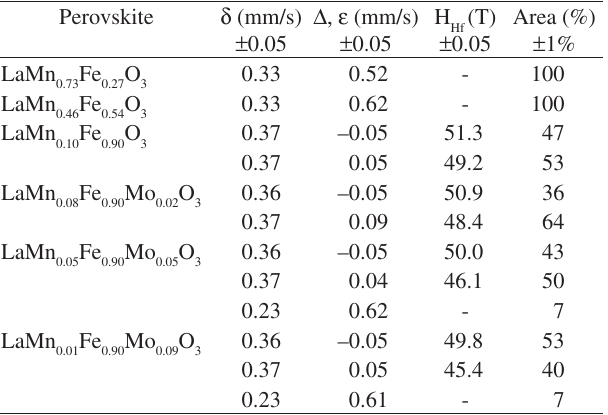
Table 1. Mössbauer hyperfine parameters for the LaMn LaMn Fe Mo O perovskites. 0.1-x 0.90 x 3